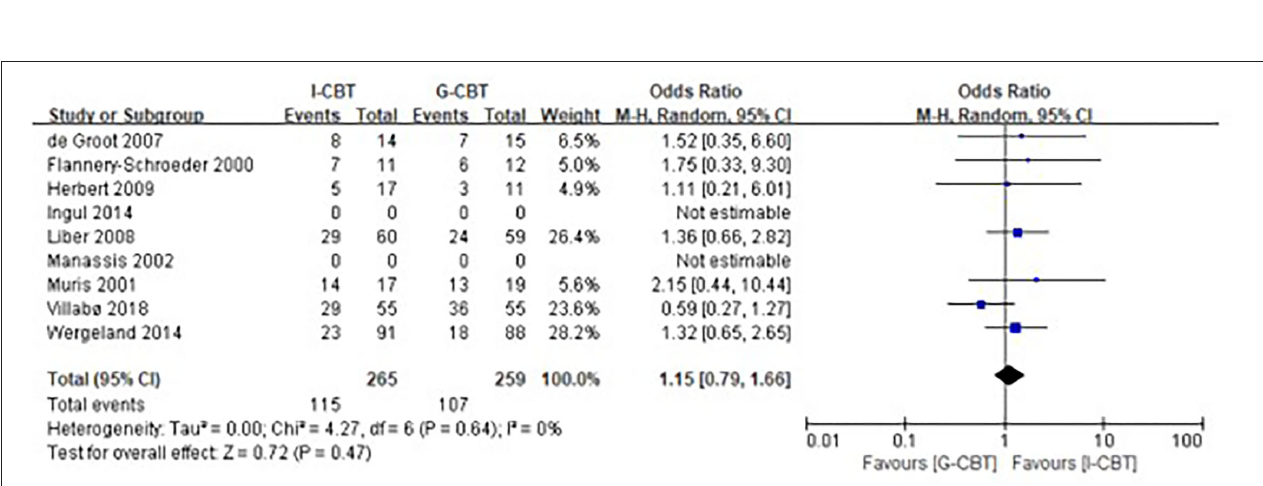
FIGURE 3 | Meta-analysis of the rate of remission. Forest plot of odds ratios (with 95% confidence intervals) of remission at post-treatment in the comparison between individual cognitive behavior therapy and group cognitive behavior therapy.